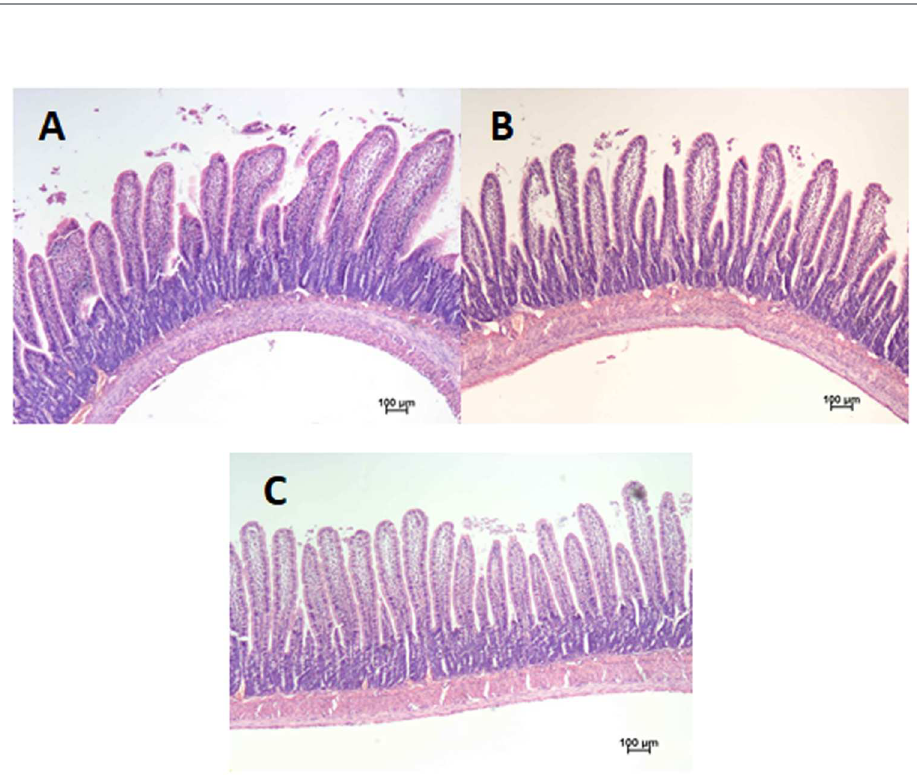
Fig 1. Morphological effects of different Cu sources on rat intestine—(A) CuD group; (B) CuS-H, CuS-L i CuNP-L groups; (C) CuNP-H group (magnification 10×).